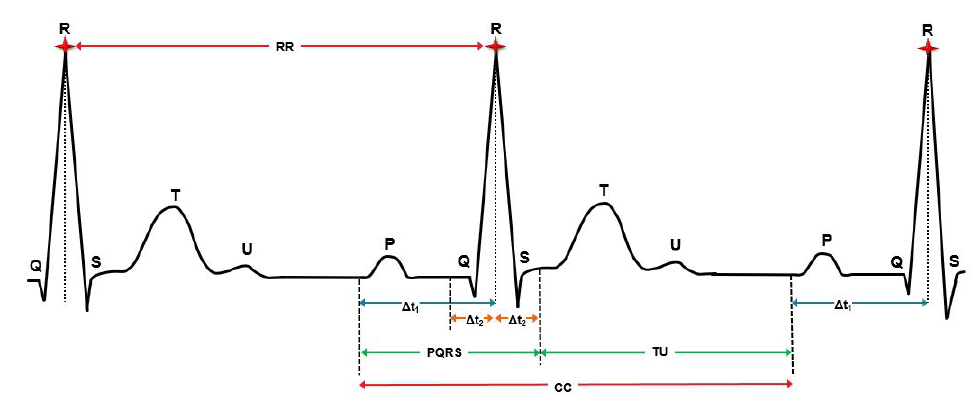
Figure 1. Cardiac cycle (CC) with its PQRS and TU segments, and associated RR interval according to extended segmented beat modulation method